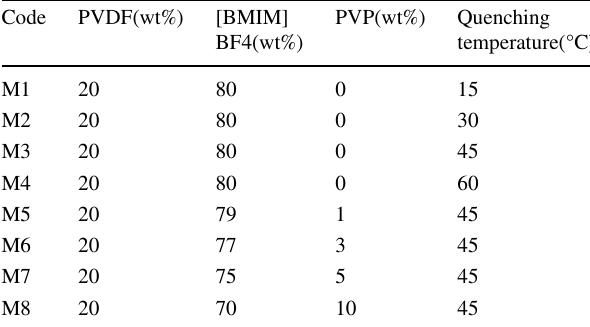
Table 2 Dope compositions used for membrane preparation